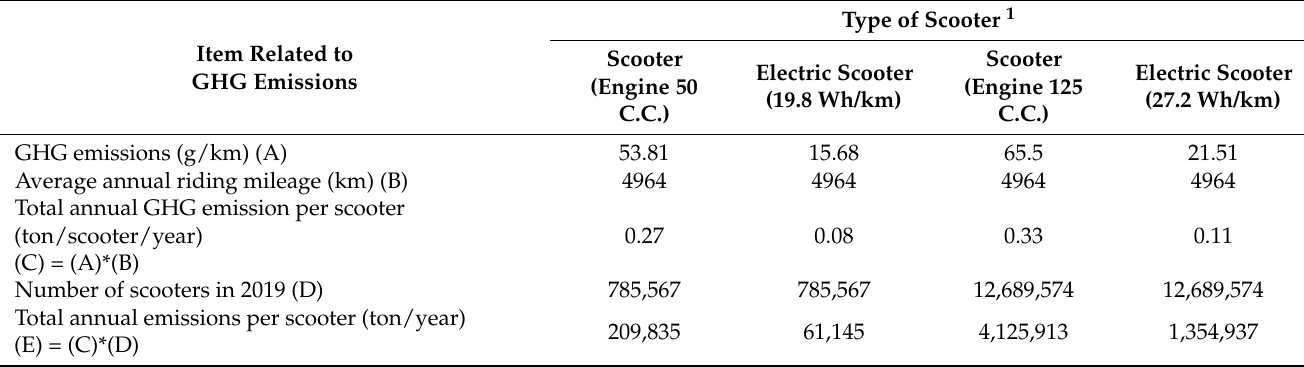
Table 8. Annual GHG emission for each type of